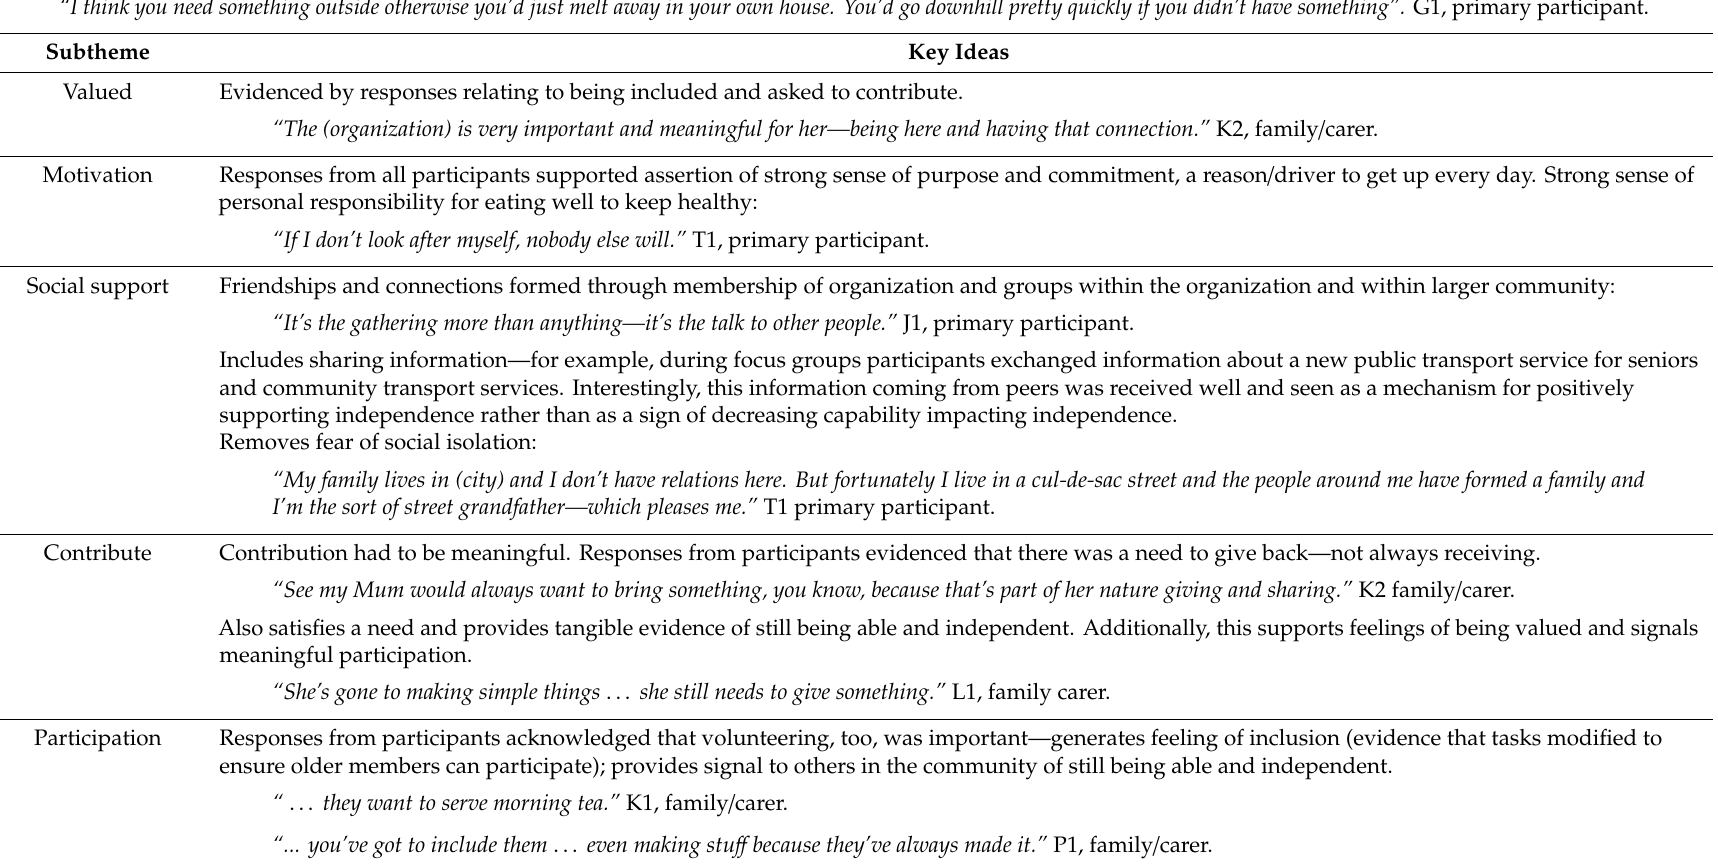
Table 1. Summary of key ideas underpinning themes and